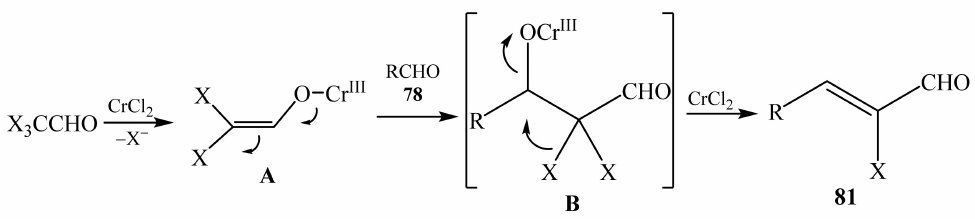
Scheme 34. A tentative mechanism of the reaction halo-homologation of